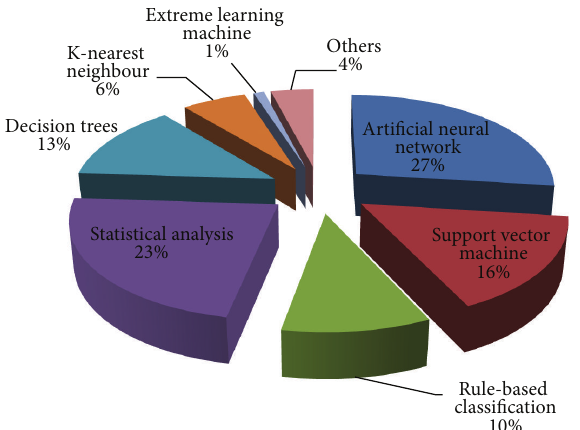
Figure 5: Illustration of classification methods as used by existing diagnostic